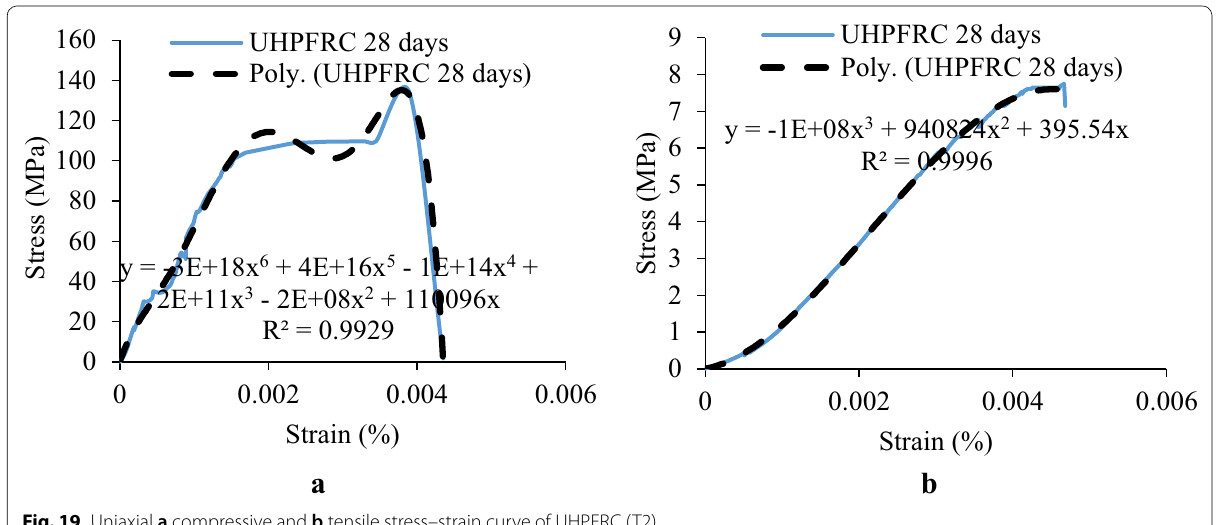
Fig. 19 Uniaxial a compressive and b tensile stress–strain curve of UHPFRC